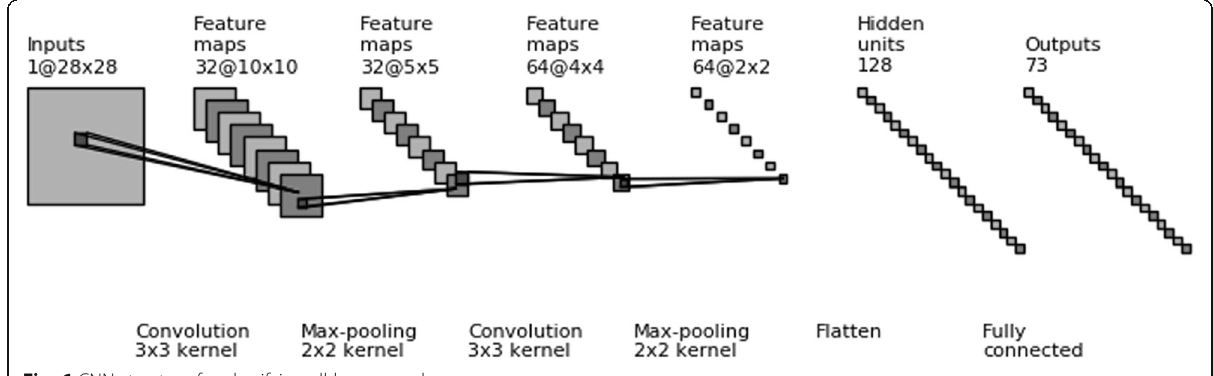
Fig. 6 CNN structure for classifying all lung